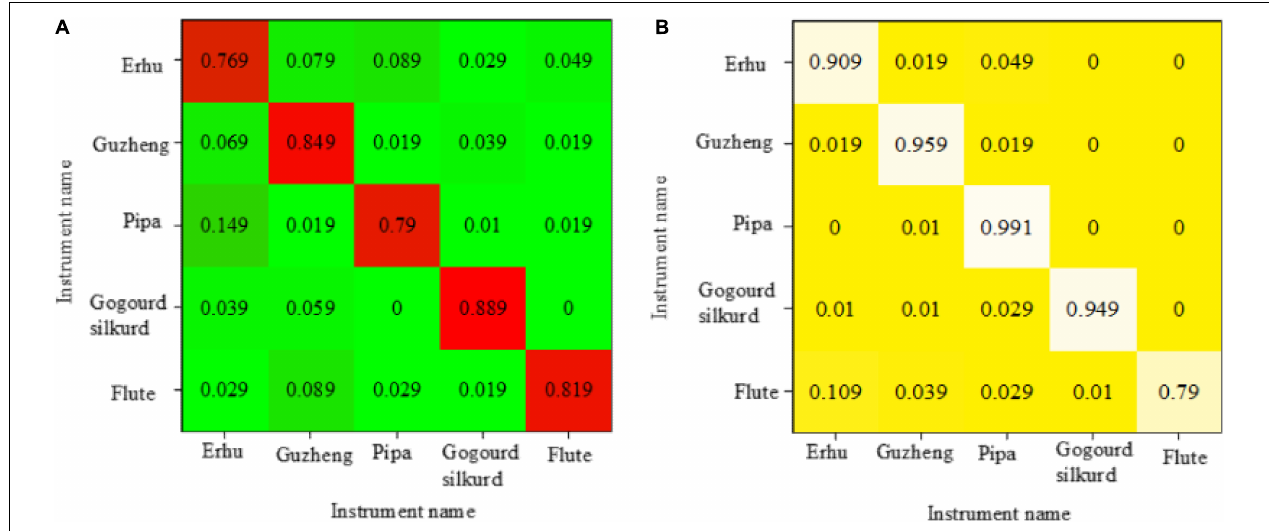
FIGURE 10 | The confusion matrix composed of recognition rates [ (A) recognition rate confusion matrix of distinguishing national musical instruments by distinguishing trees; (B) recognition rate confusion matrix of distinguishing national musical instruments by KNN].